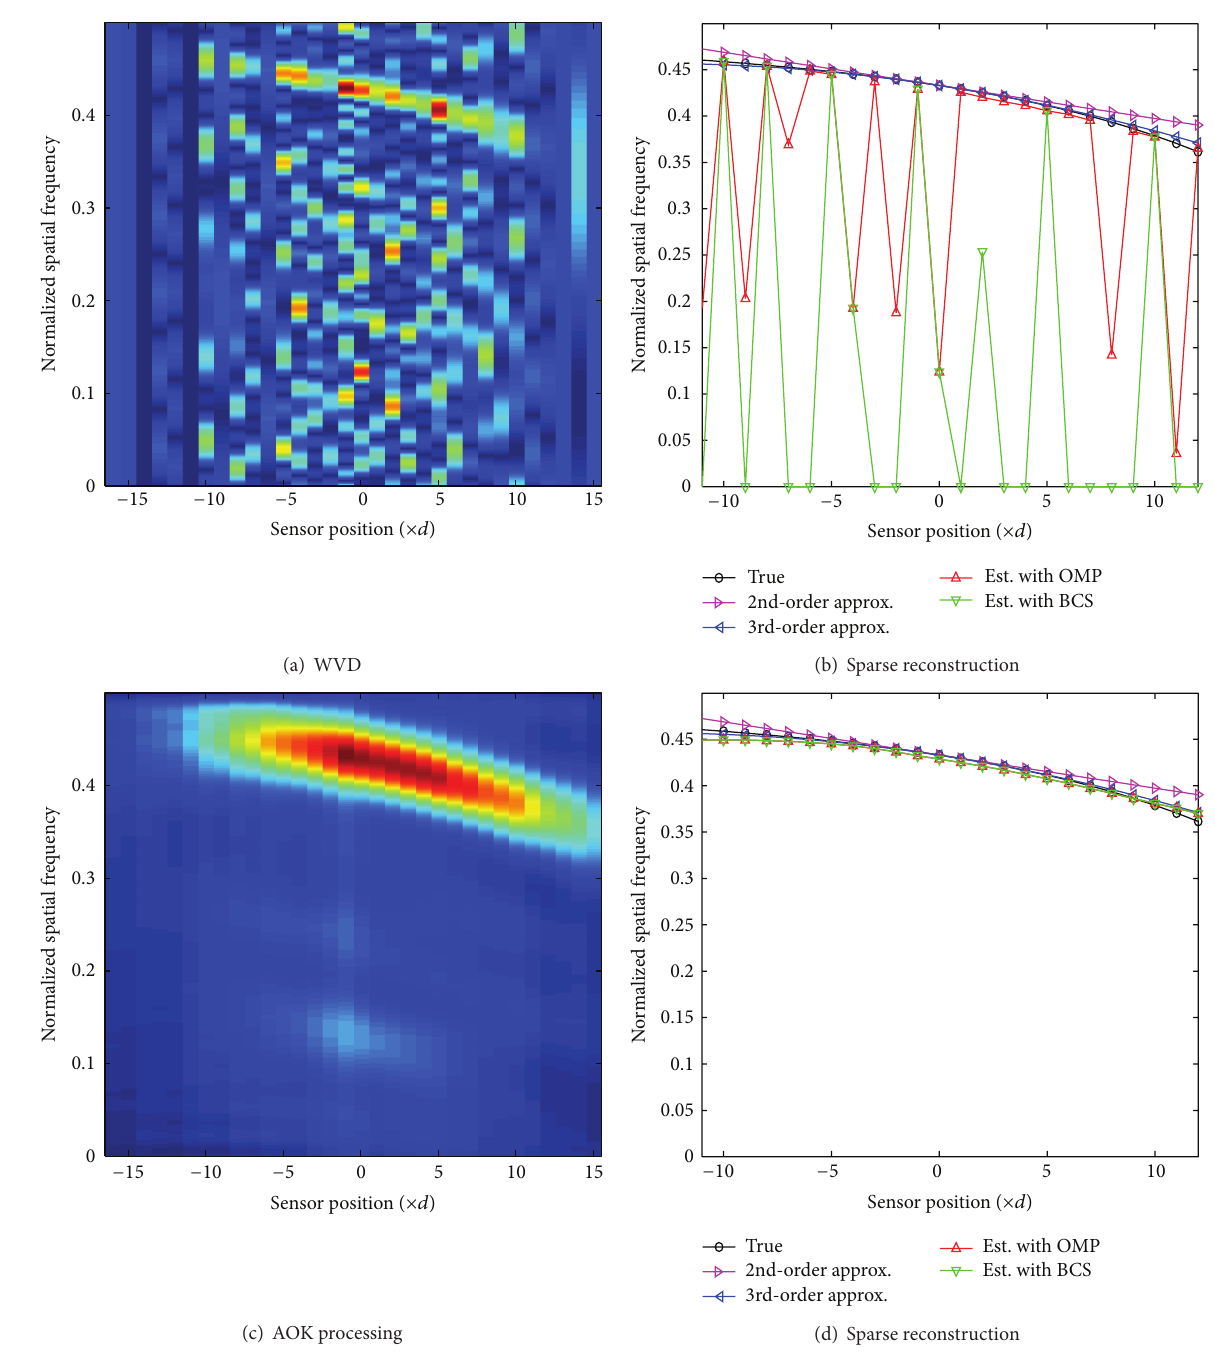
Figure 8: Near-field source location estimation using the sparse array ( 𝑟 1 = 350 m, 𝜃 1 = 30 ∘ ).